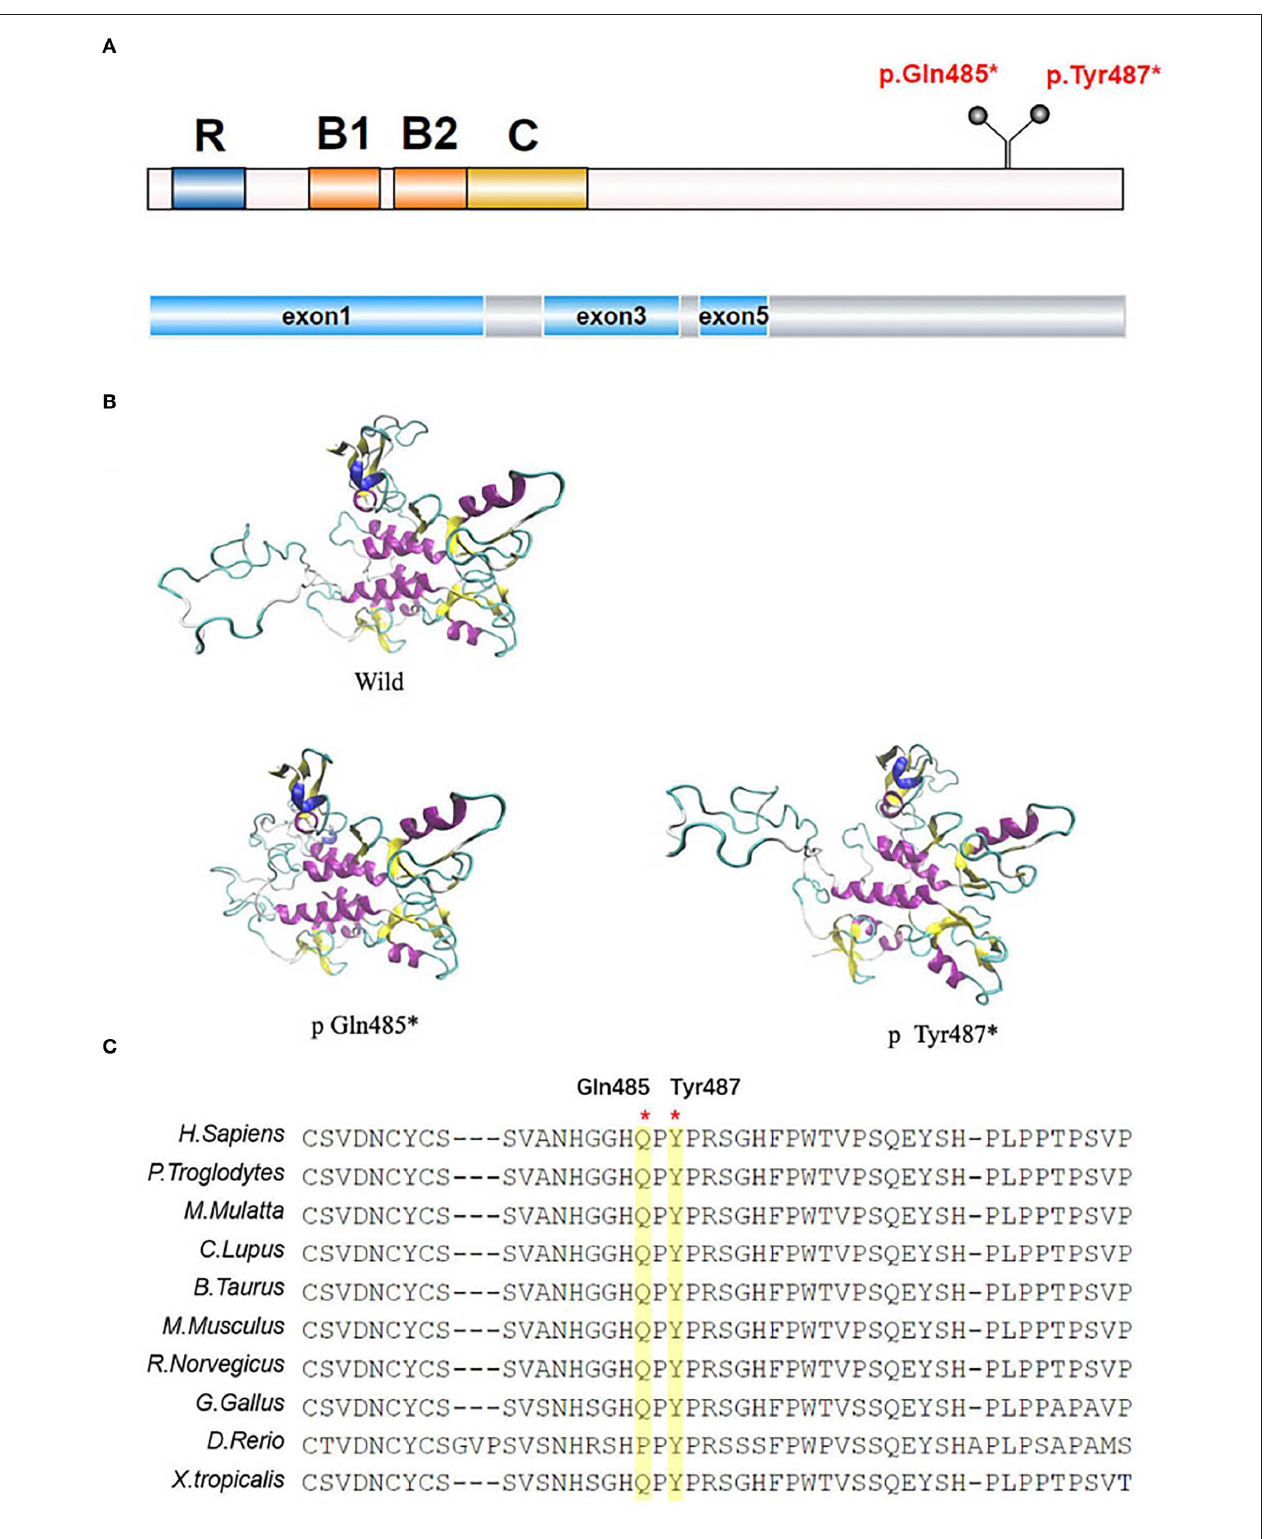
FIGURE 3 | TRIM8 gene mutations. (A) The location of the two de novo nonsense TRIM8 mutations. TRIM8 contains a RING domain at the N-terminal, two B-box motifs (B1 and B2), a Coiled-Coil domain, a Nuclear Localization Signal (NLS) and an RFL-like domain at the C-terminal. (B) Structural modeling of TRIM8 mutations. (C) Multiple sequence alignment showing the conservation of the two amino acids between